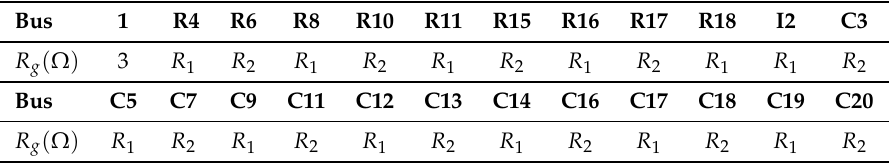
Table 5. Neutral ground resistances at each bus.